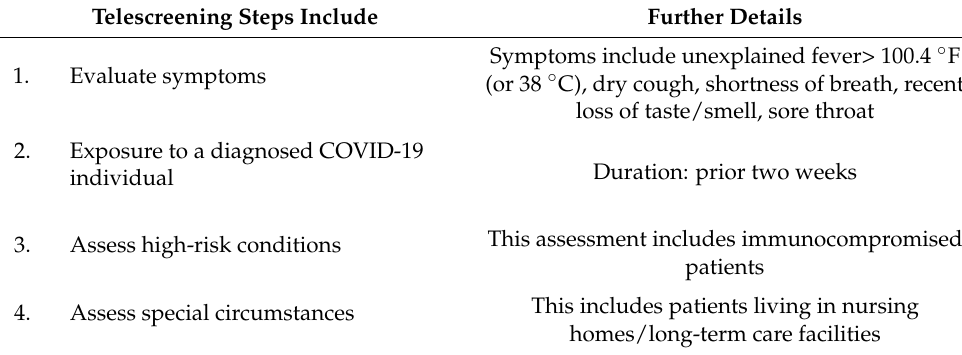
Table 2. Phone Advice and initial